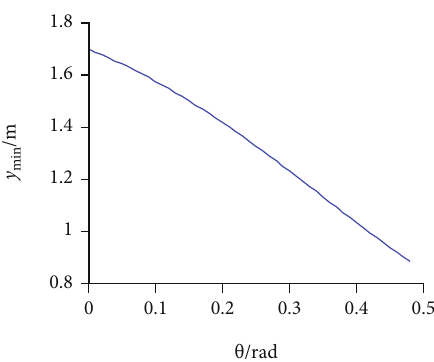
Figure 19: Minimum displacement of the body from the lunar surface vs. the lunar surface inclination.